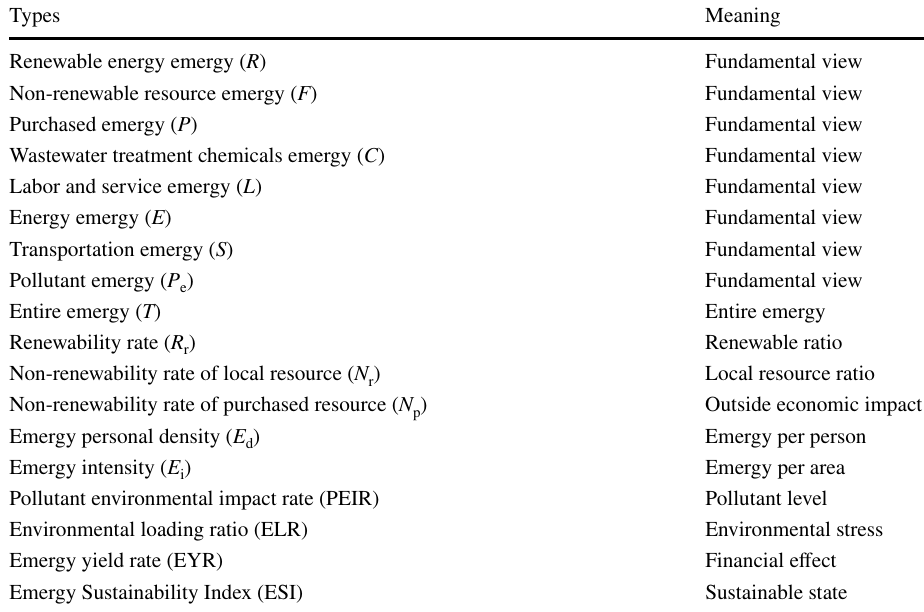
Table 2 Total indexes in two sludge reuse systems